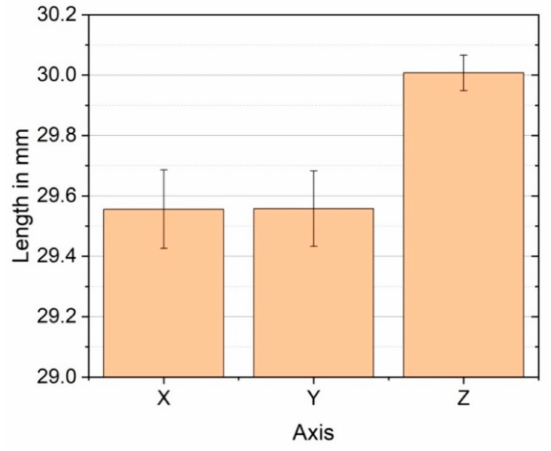
Figure 8. Shrinkage in each printing direction for cubic specimens 30 mm × 30 mm × 30